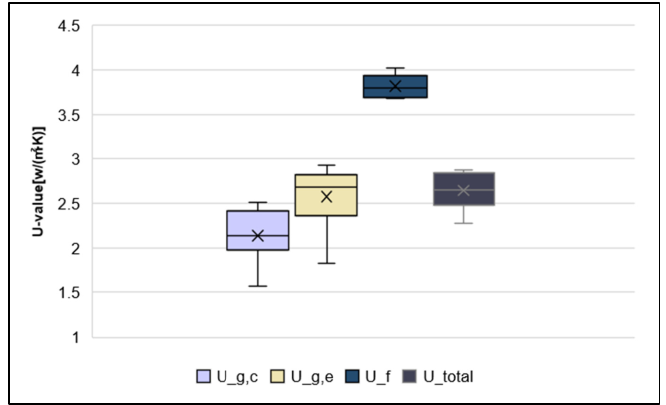
Figure 26. Boxplot of U-value Results Using IR Case 1 [36].